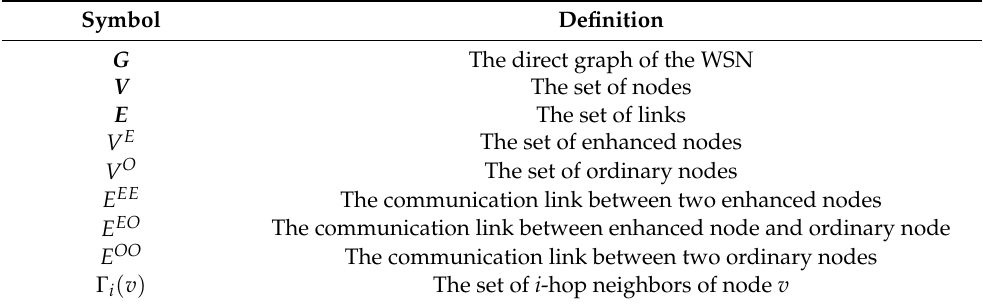
Table 1. Definition of the symbols.